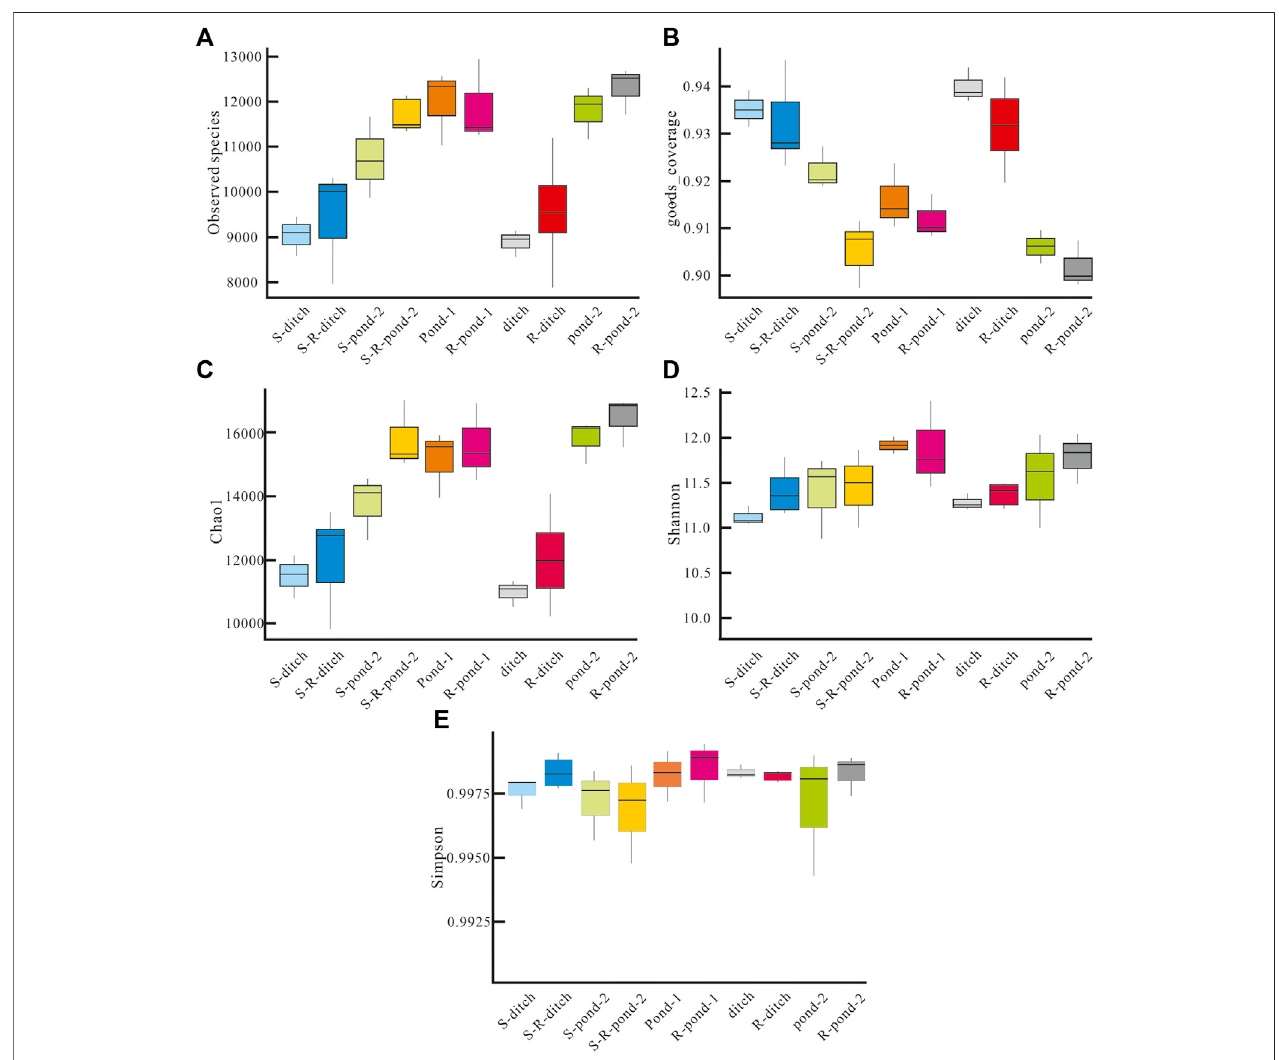
FIGURE 6 | Richness and diversity of rhizosphere and non-rhizosphere sediment bacteria in two systems. (A) Numbers of observed species, (B) the values of goodscoverage, (C) theChao1index, (D) theShannonindex,and (E) theSimpsonindexofnon-rhizosphereandrhizospheresedimentbacteriaindifferentmicrocosms of two systems. S-ditch and S-R-ditch meant non-rhizosphere and rhizosphere ditch groups in the static system, respectively; Similarly, S-pond-2, and S-R-pond-2 meant non-rhizosphere and rhizosphere pond-2 groups in the static system, respectively. The same naming rules were applicable in pond-1, R-pond-1, ditch, R-ditch, pond-2, and R-pond-2 in the